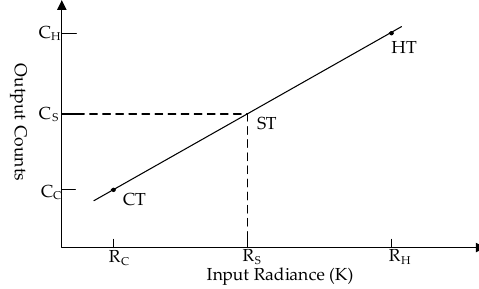
Figure 12. Linear relationship between counts and radiance.